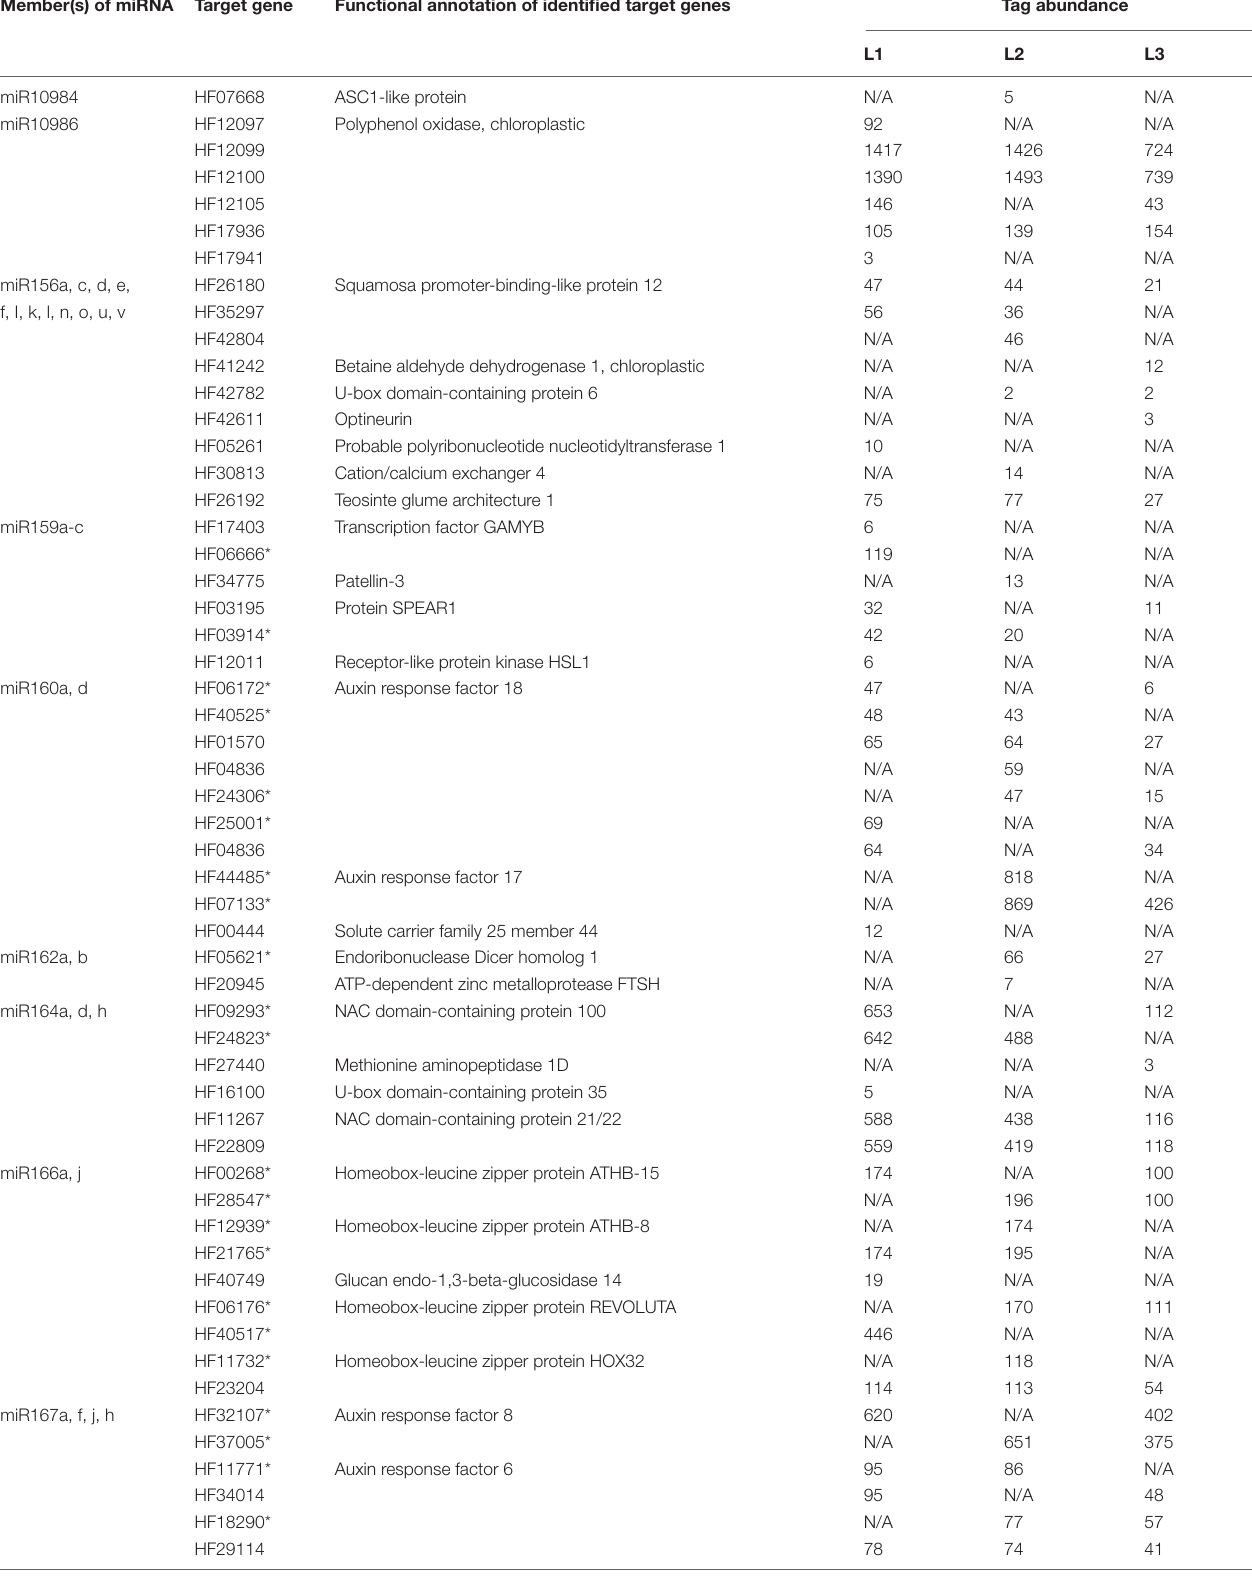
TABLE 4 | Identified target genes, their functional annotations and detected tag abundance in apple roots in response to Pythium ultimum infection. Member(s) of miRNA Target gene Functional annotation of identified target